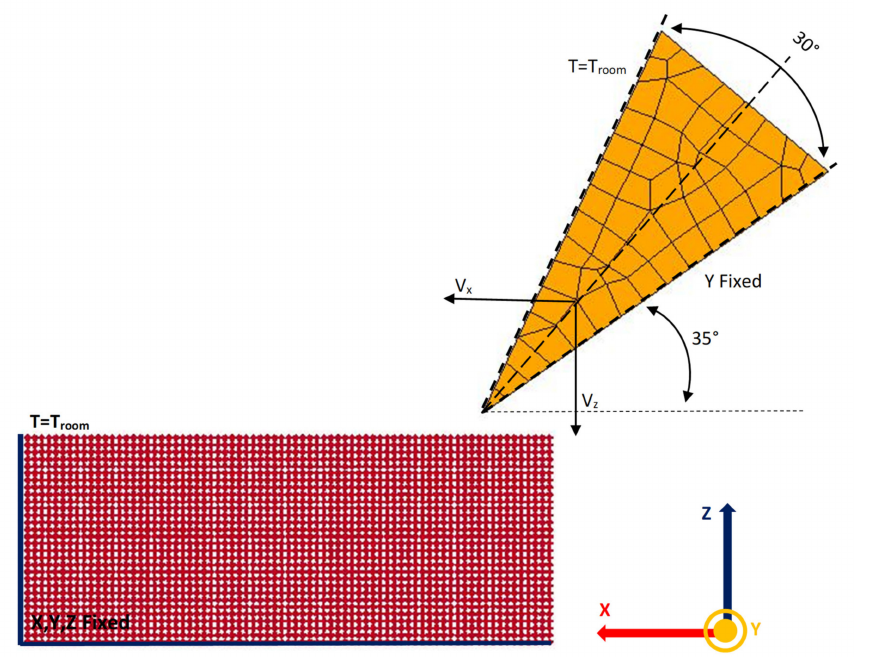
Figure 5. Meshing and boundary conditions for workpiece and tool in LS